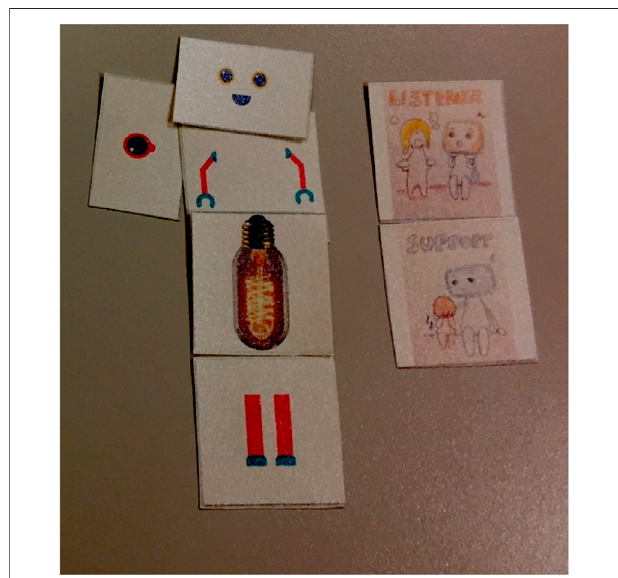
FIGURE 2 | Sample of a completed robot prototypes from the card